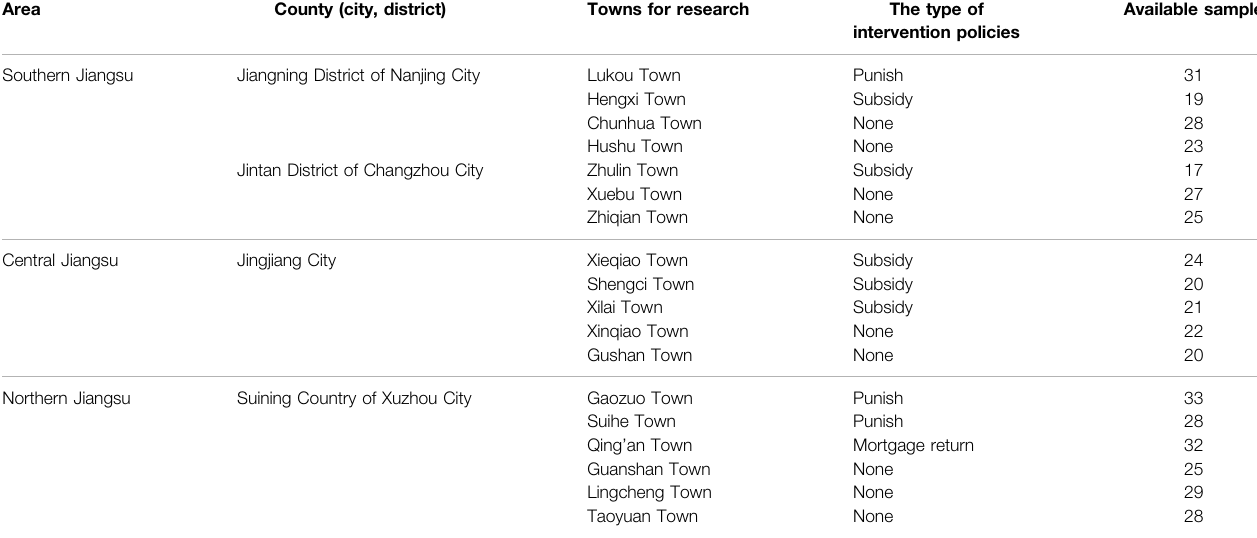
TABLE 4 | Distribution of